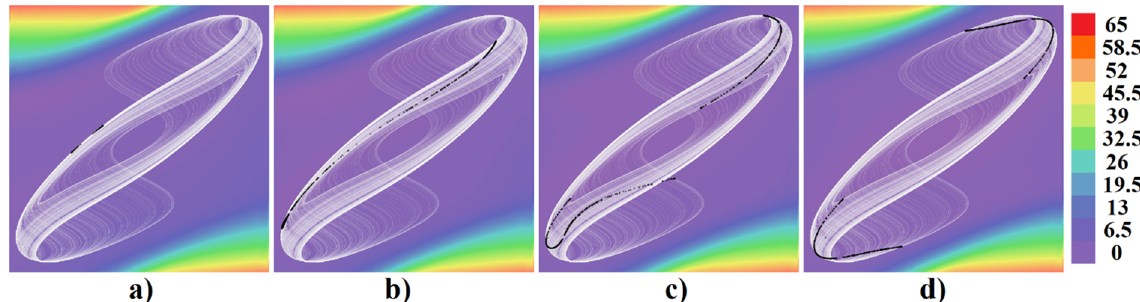
Figure 8. Distribution of kinetic energy normalized to final time 1 s over the state space for chaotic attractor generated by the second case of third order system. Poincaré sections (black dots) are taken as intersections of state trajectory (white curve) with horizontal planes defined by: ( a ) z = −3.3, ( b ) z = −2, ( c ) z = −1, ( d ) z = 0.